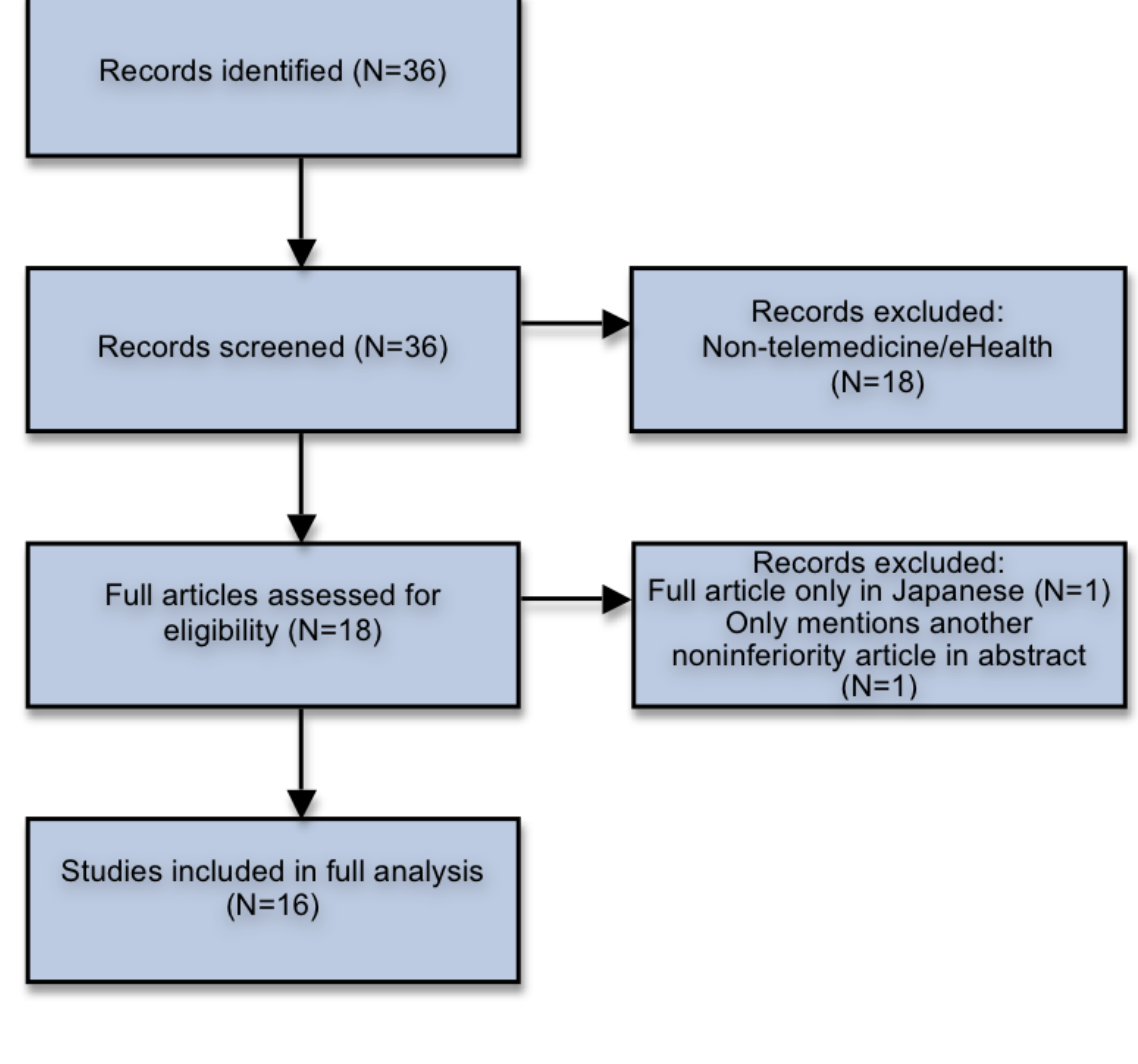
Figure 1. Strategy